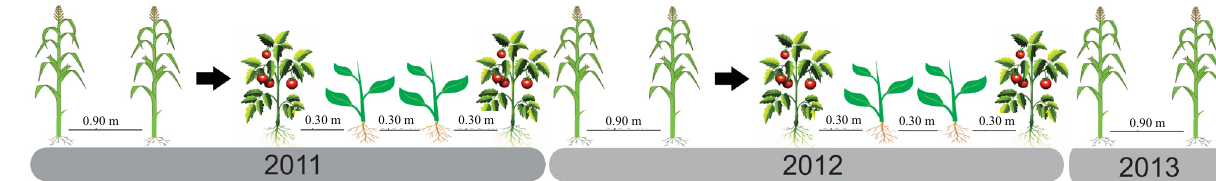
Figure 2. Illustration of succession system of green corn and cherry tomato/legumes with their respective spacing between the lines.